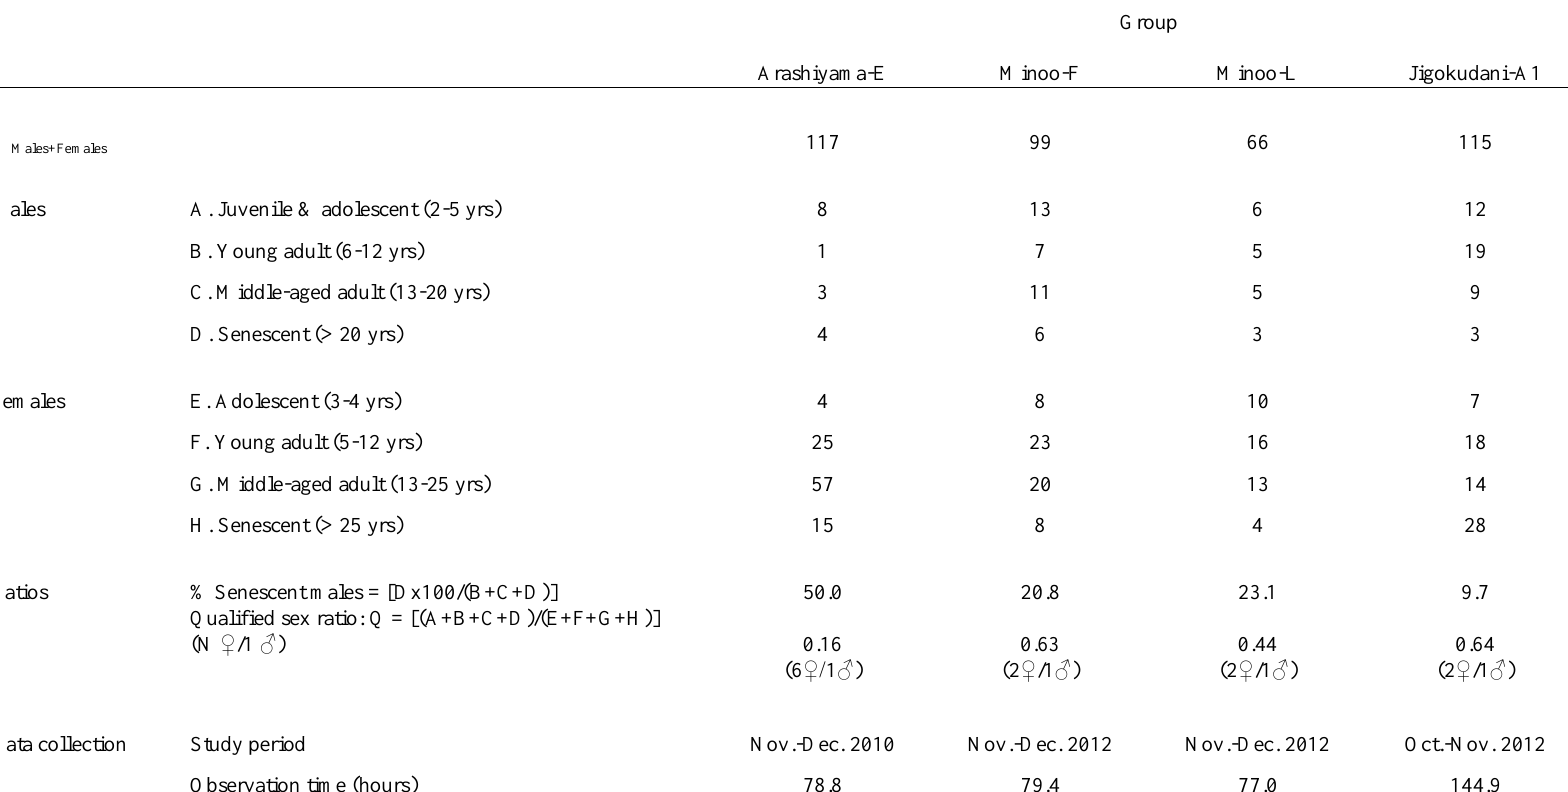
The Four Study Groups: Composition by Age and Sex Classes of Individuals Developmentally Capable to Engage in FMM and FFM, and Data Collection Schedule